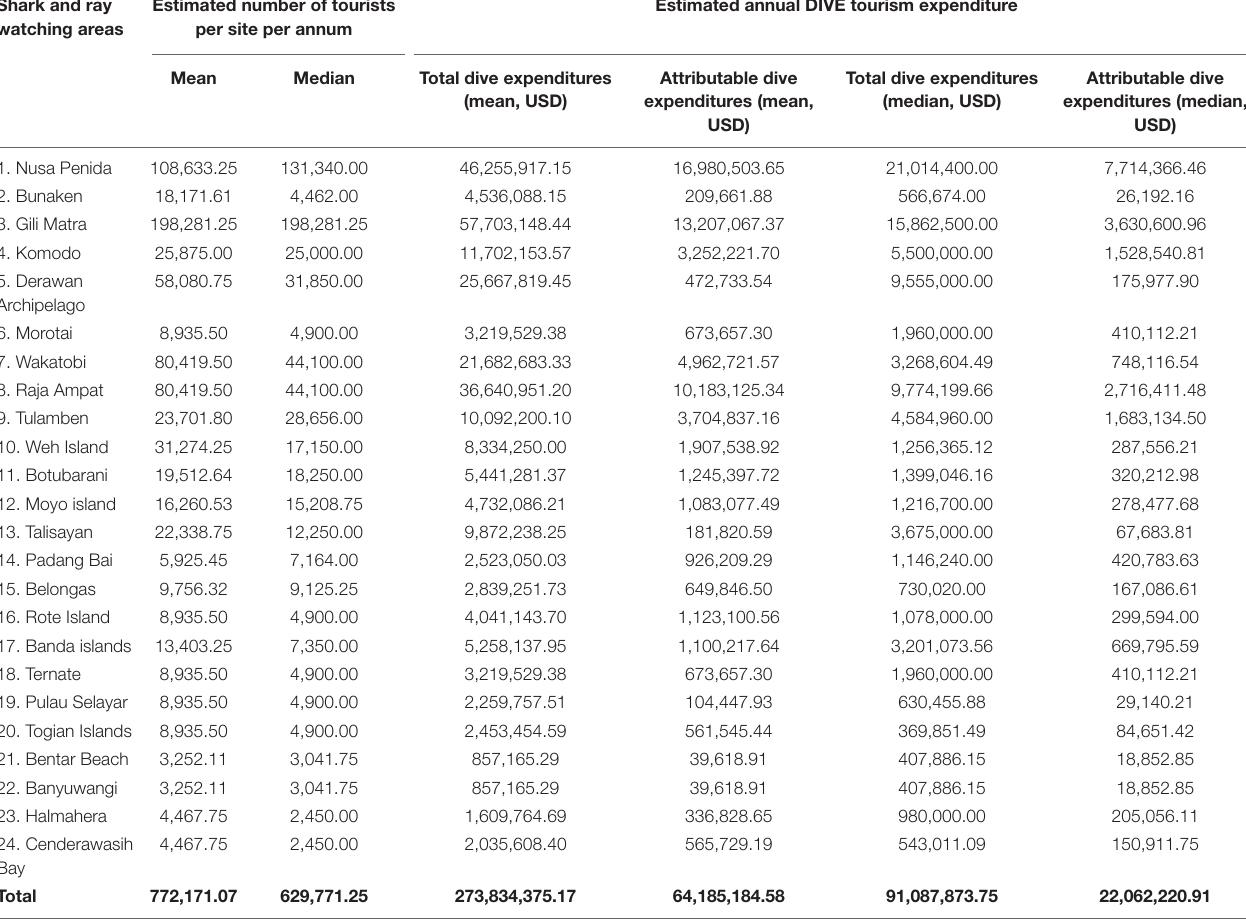
TABLE 4B | Estimated annual shark and ray expenditures (USD) for 235 dive operators in Indonesia. Shark and ray Estimated number of tourists watching areas per site per